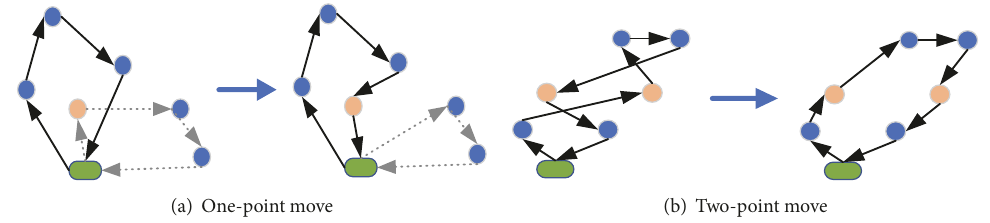
Figure 3: Improvement operators used in